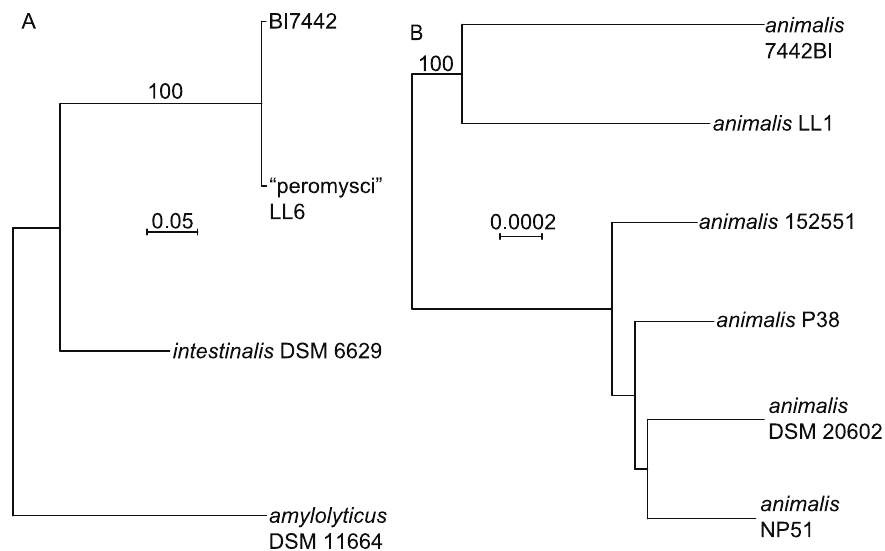
Fig 15. Distance phylograms of concatenated codon-aligned nucleotide sequences of two Lactobacillus spp. of P . leucopus of Block Island, Rhode Island. Panel A, 10,152 positions of ftsK , ftsZ , dnaA , dnaN , ileS , and topA of “L. peromysci” LL6 and BI7442 and two other Lactobacillus species. Panel B, 18,552 positions of 51 of 53 ribosomal protein genes of six L . animalis strains, including LL1 and 7442BI. The distance criteria were Jukes-Cantor. The scales for distance are shown in each panel. Percent bootstrap (100 iterations) support values of � 80% at a node are shown.